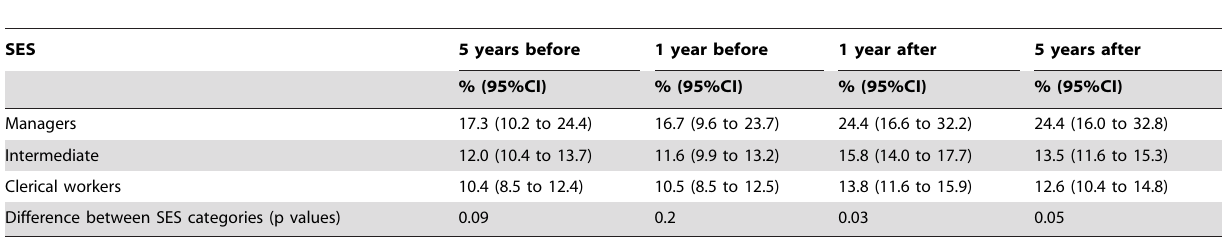
Table 4. Proportion (95% confidence intervals [95%CI]) of heavy drinkers in relation to retirement, by SES in women (from generalised estimation equations modelling).